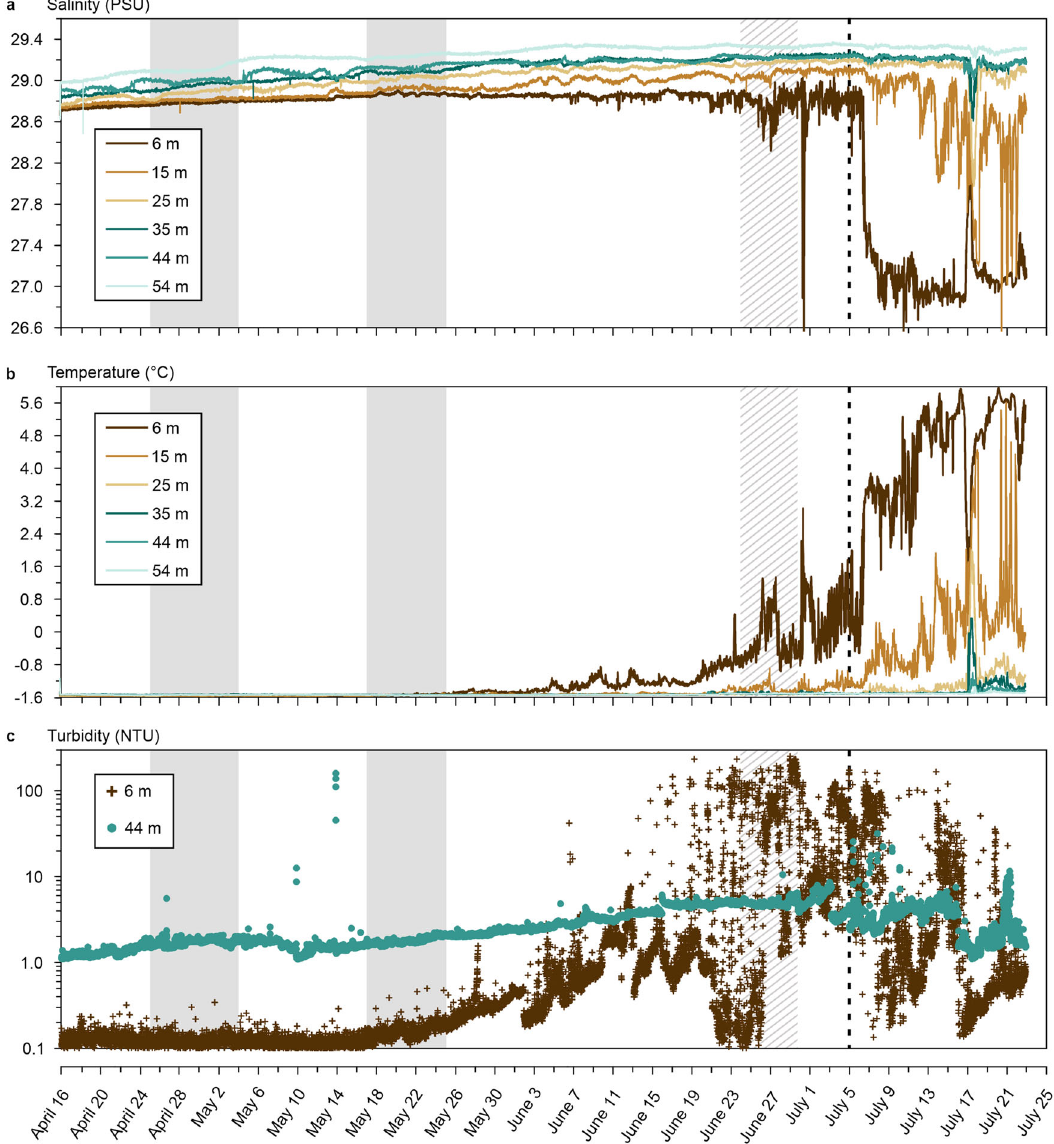
Fig. 2 Temperature, salinity and turbidity pro fi les from the mooring line. a Salinity (PSU), ( b ) temperature (°C), and ( c ) turbidity pro fi les (NTU) measured at the mooring site at 6, 15, 25, 35, 44, and 54 metre depths. Note the logarithmic scale of the turbidity pro fi le. The ice and water sampling periods are marked with solid grey, the end of the sediment trap sampling period with a dashed black line, and the ice breakup period with a dashed grey